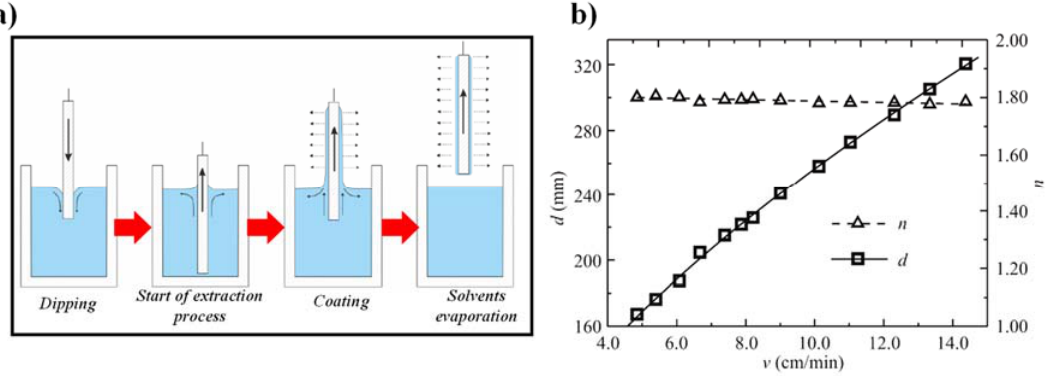
Figure 9. ( a ) Graphical illustration of a dip-coating method for the deposition of SiO 2 -TiO 2 WG layers [35], ( b ) Dependence of the sample extraction speed from the sol on the WG film thickness and the RI, respectively [180].